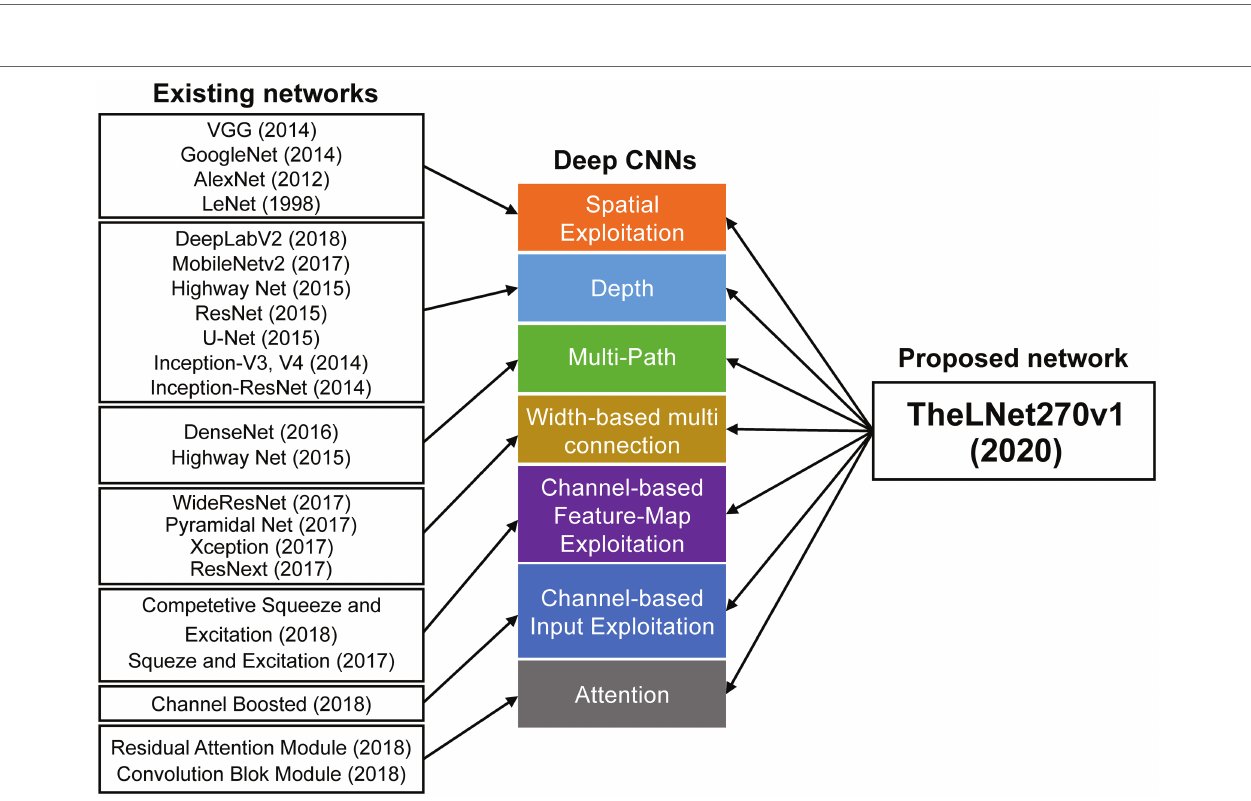
FIGURE 1 | A schematic representation of a thermal camera working principle. 1: surroundings, 2: object, 3: atmosphere, 4: thermal camera, and 5: thermal image.